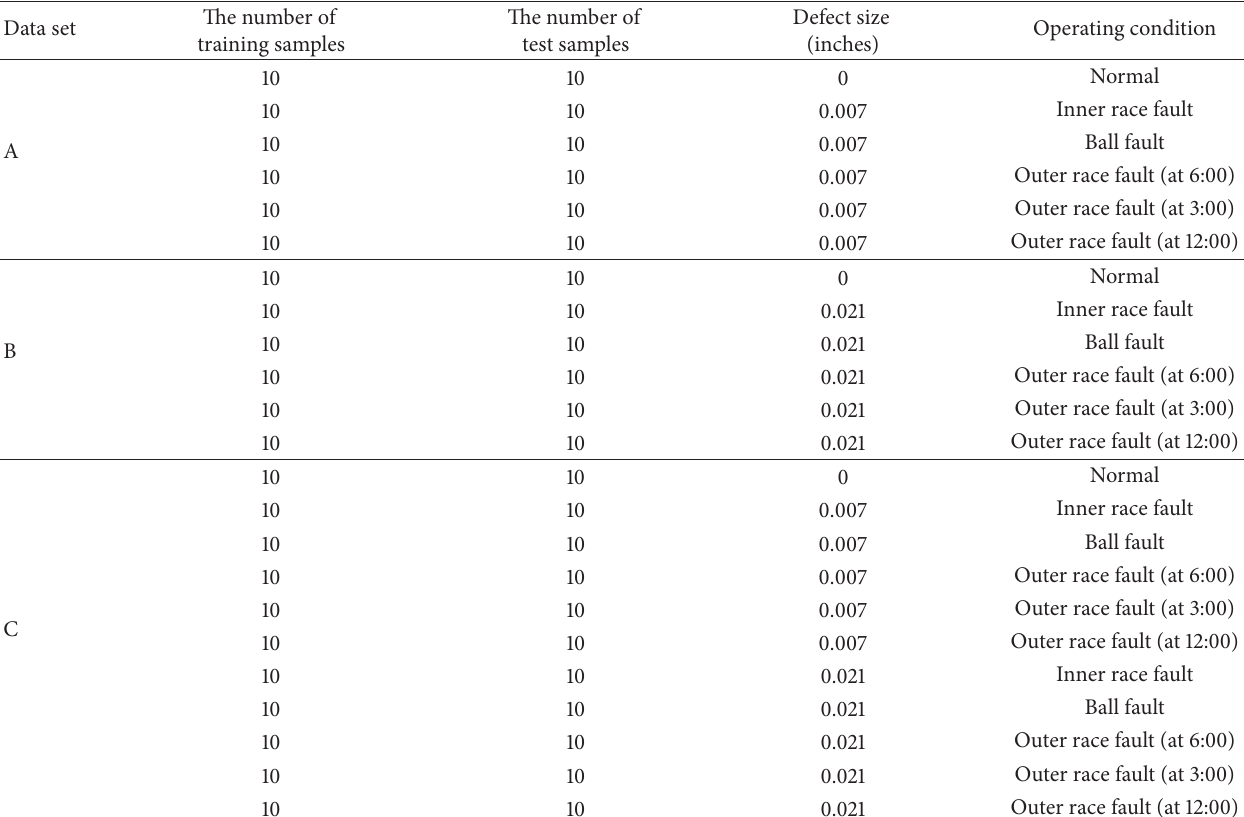
Figure 12: Detection results of data set B with an outer fault located at 12:00 according to morphology spectrum correlation analysis: (a) signal based triangular SE; (b) flat SE. Table 2: Details of data sets A, B, and